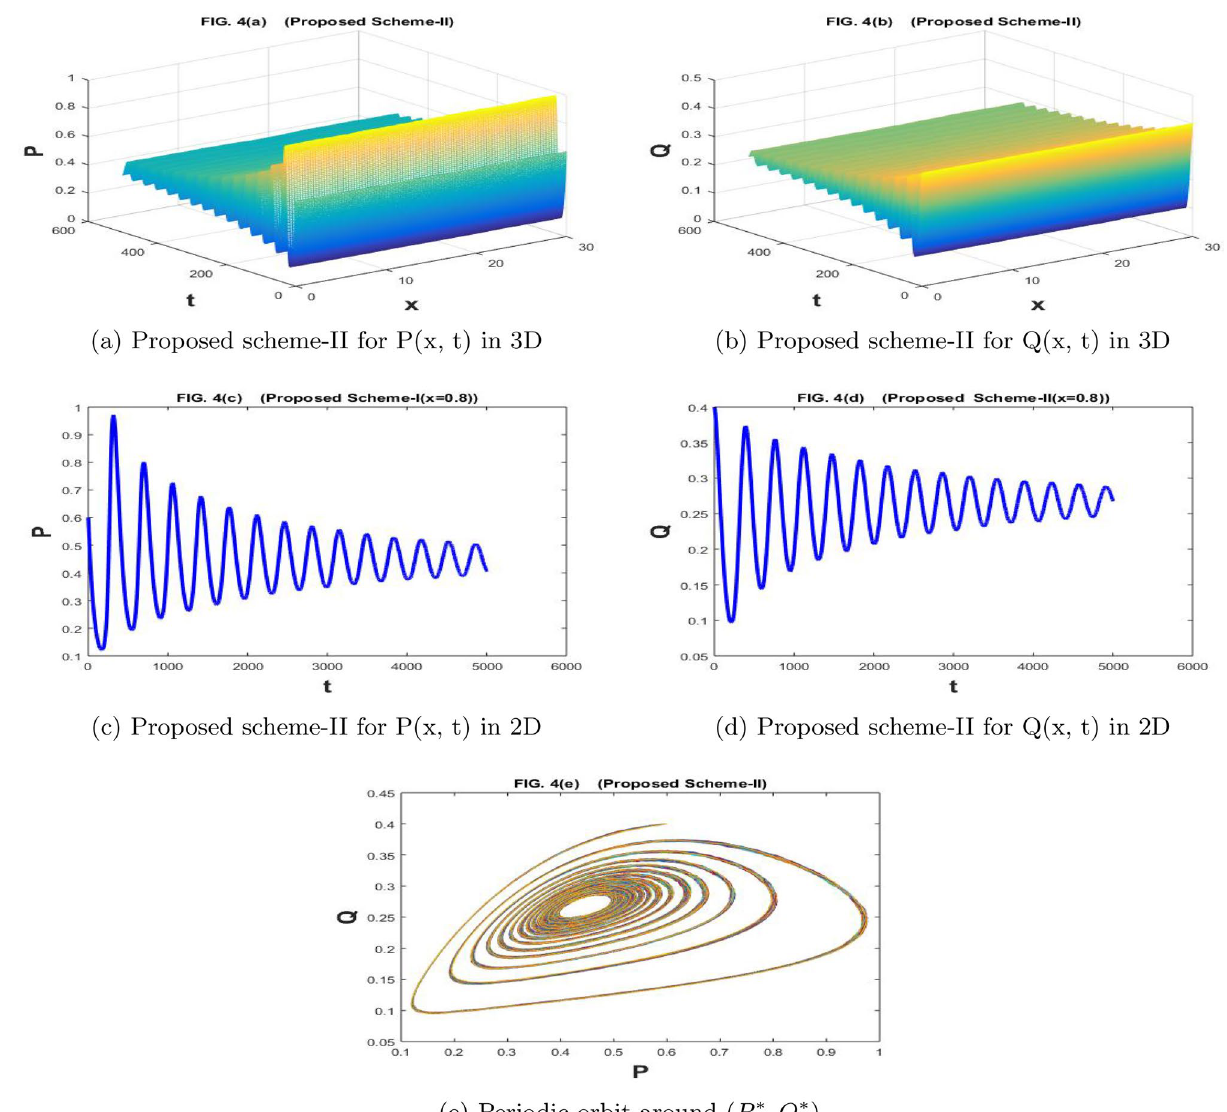
Figure 4. The subfig ( a and c ) and ( b and d ) represents the numerical approximation of P ( x , t ), and Q ( x , t ) respectively by proposed scheme-II. The subfig ( e ) represents the periodic orbit around ( P ∗ , Q ∗ )